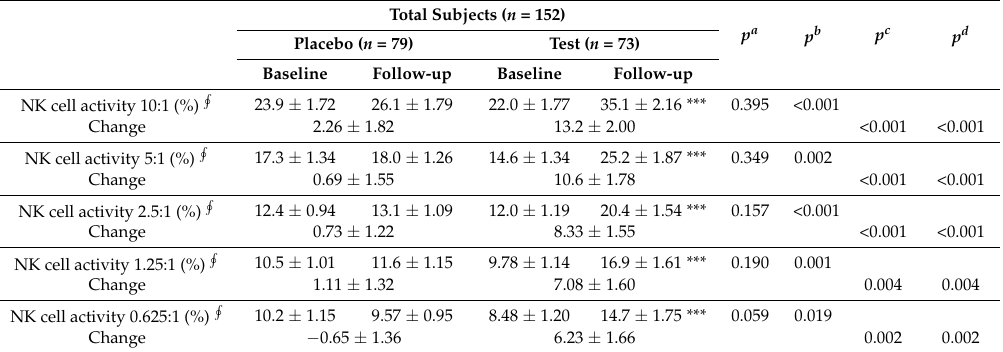
Table 2. Effects on natural killer (NK) cell activity following 12 weeks of consuming dairy yogurt containing L. paracasei , B. lactis and heat ‐ treated L. plantarum .